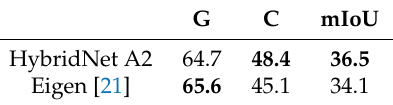
Table 7. Quantitative segmentation results on NYU V2: G, C and mIoU (best results in bold). G C